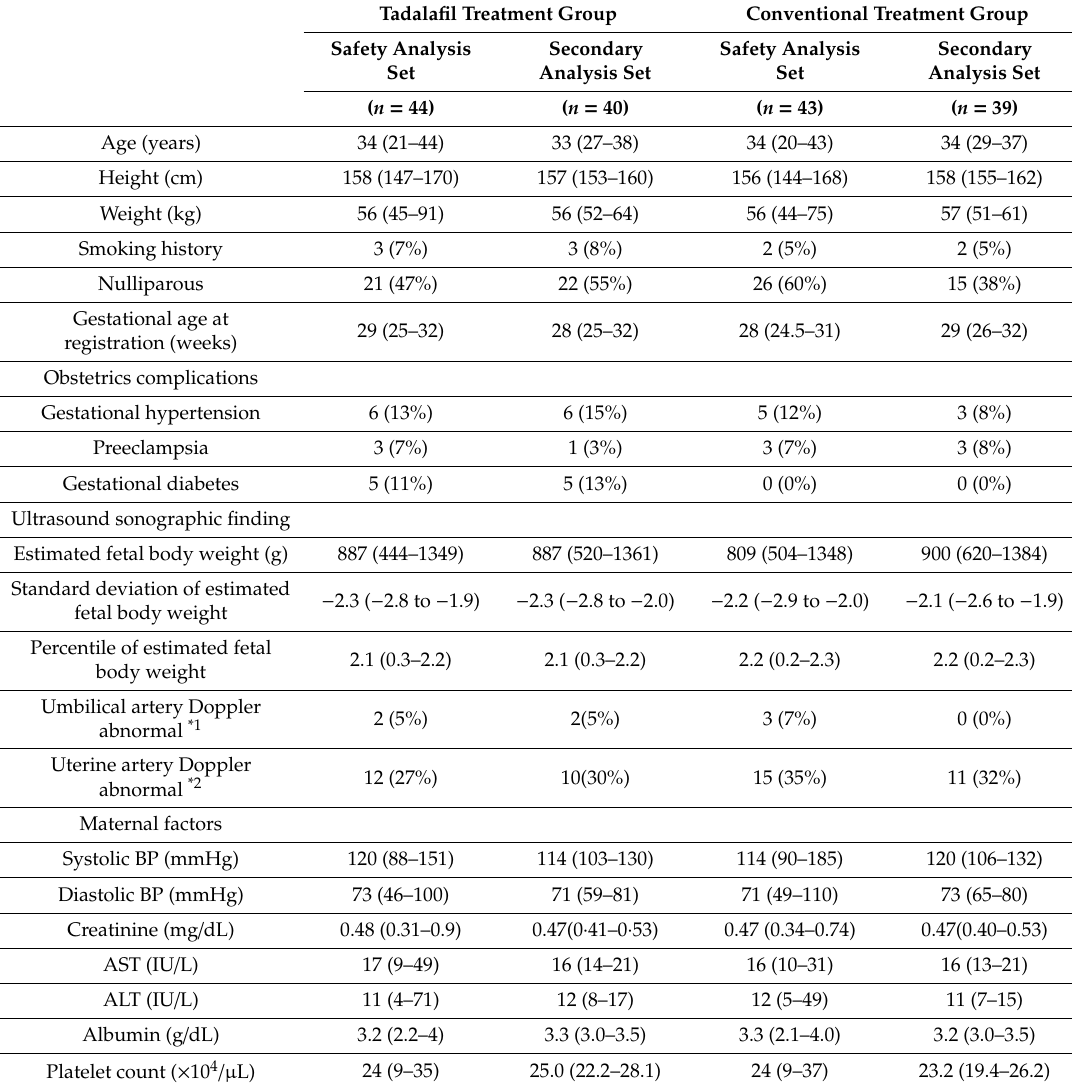
Table 2. Patient characteristics at